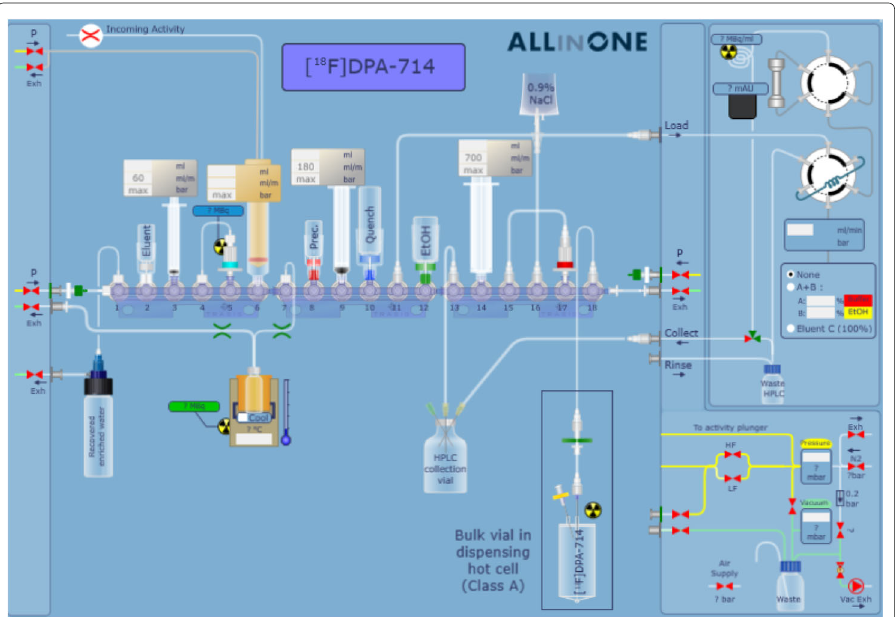
Fig. 1 Layout of the cassette designed for the radiosynthesis of [ 18 F]DPA-714 on a Trasis AIO module. The process can be controlled via the user software interface Cassette preparation